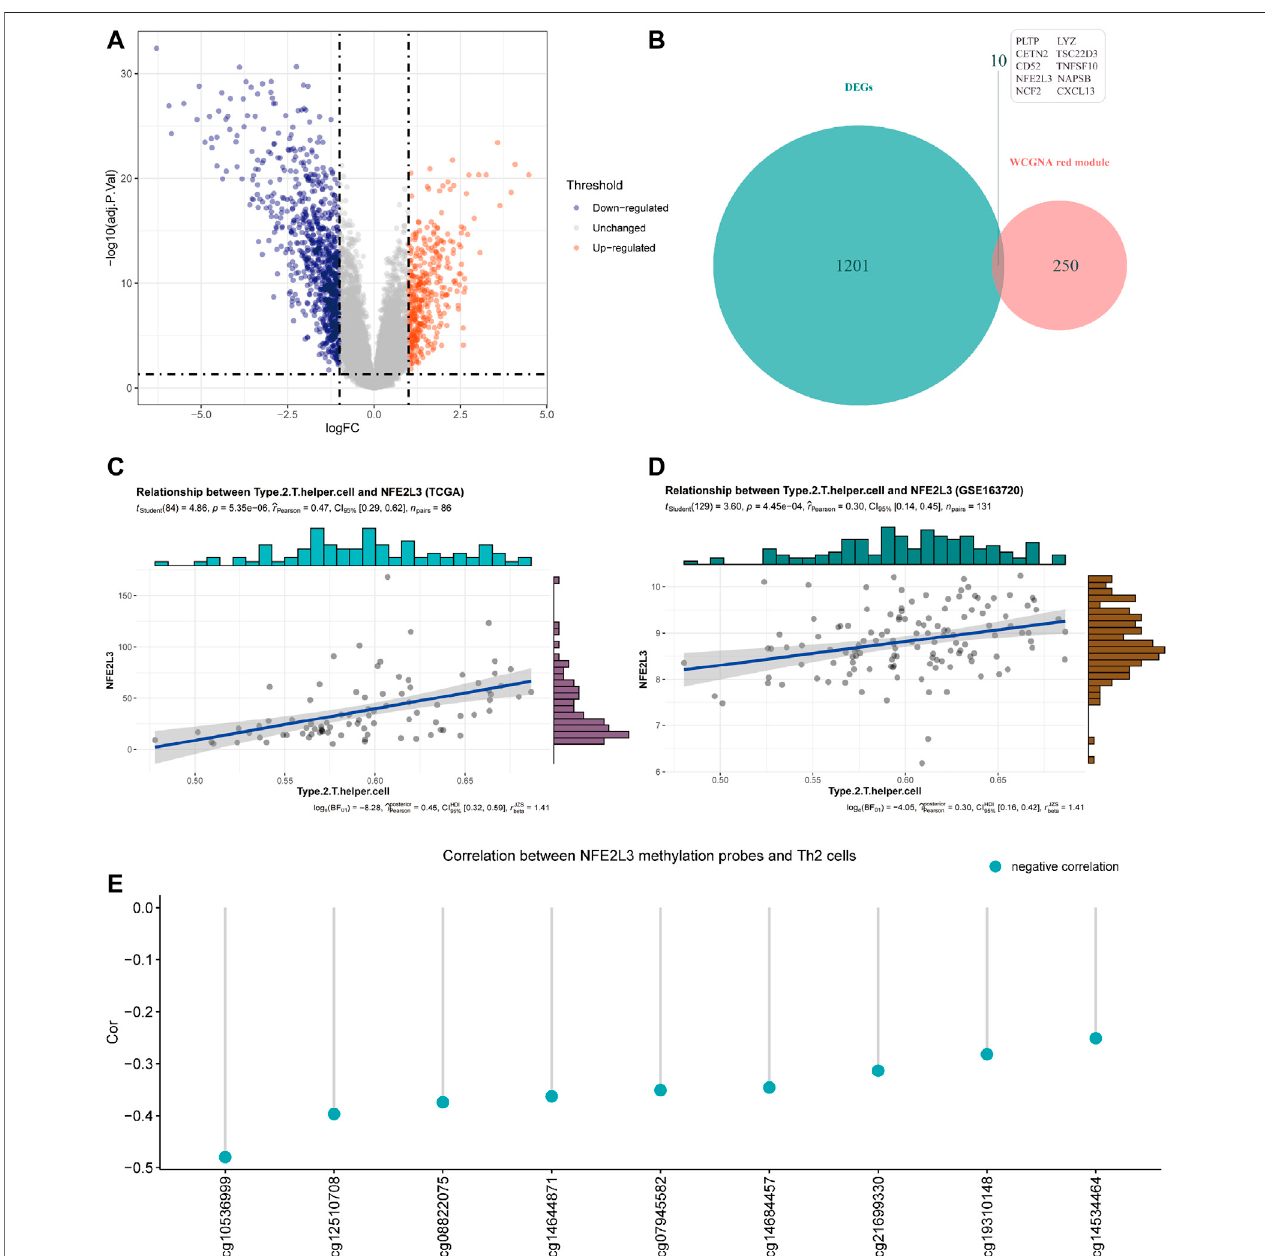
FIGURE 4 | (A) Volcano plot of differentially expressed genes (DEGs) between tumor tissues and paired normal tissues of samples from GSE51024 (adjusted p value < 0.05 and |logFC| > 1). (B) Venn plot of the intersection of DEGs from GSE51024 and genes contained in red module from WGCNA (C) Correlation between NFE2L3 expression and Th2 cell in fi ltration levels of samples from TCGA. (D) Correlation between NFE2L3 expression and Th2 cell in fi ltration levels of samples from GSE163720 (E) Correlations between DNA methylation levels of NFE2L3 related sites and Th2 cell in fi ltration levels of samples from